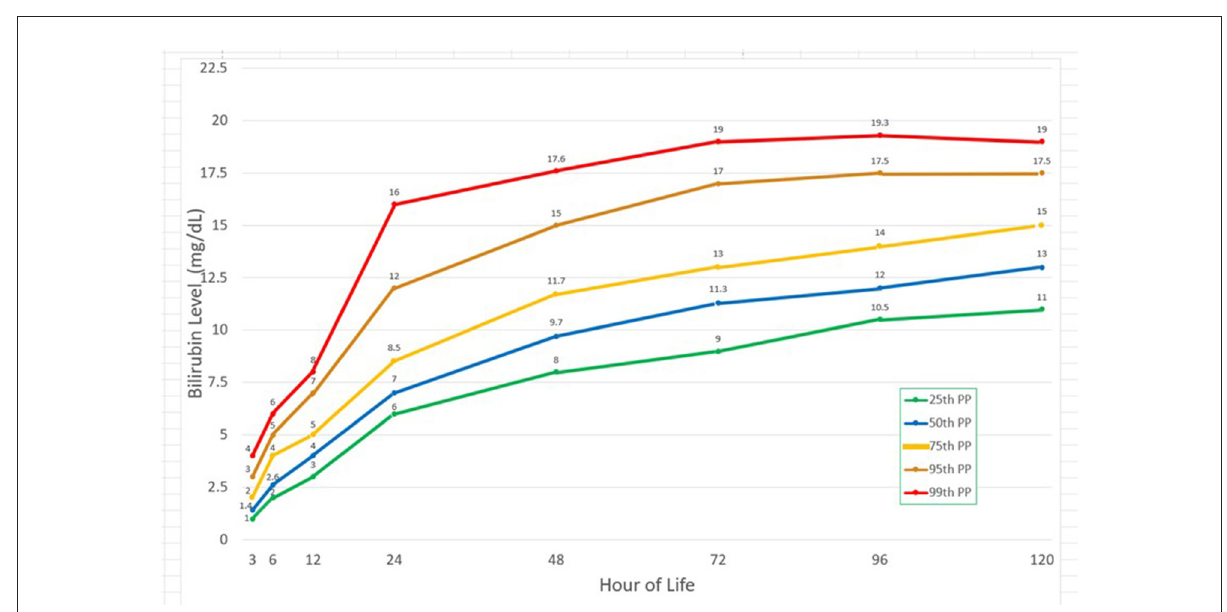
FIGURE3 Bilirubin values at different time points and corresponding 25th, 50th, 75th, 95th, and 99th percentiles.